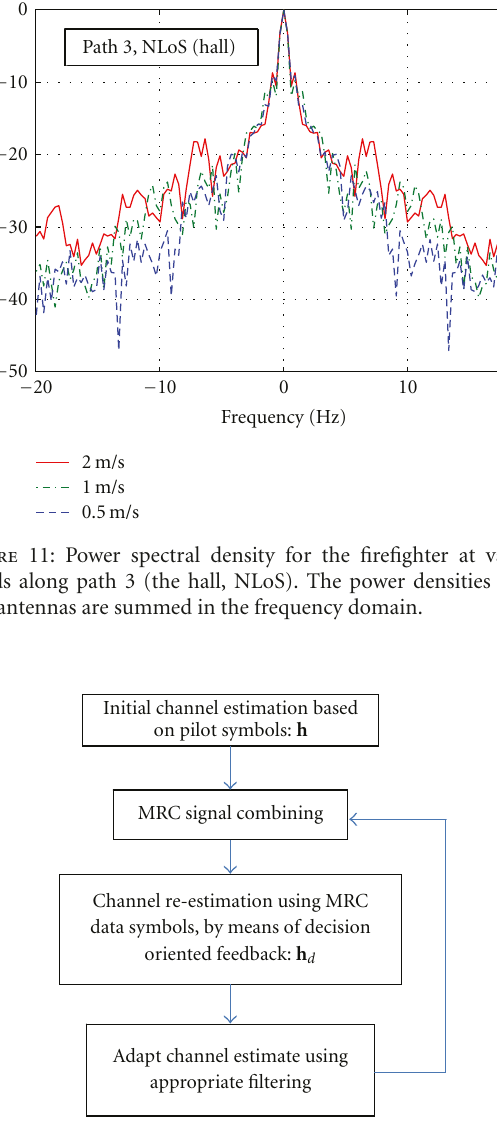
Figure 12: Flowchart of the decision-oriented feedback with